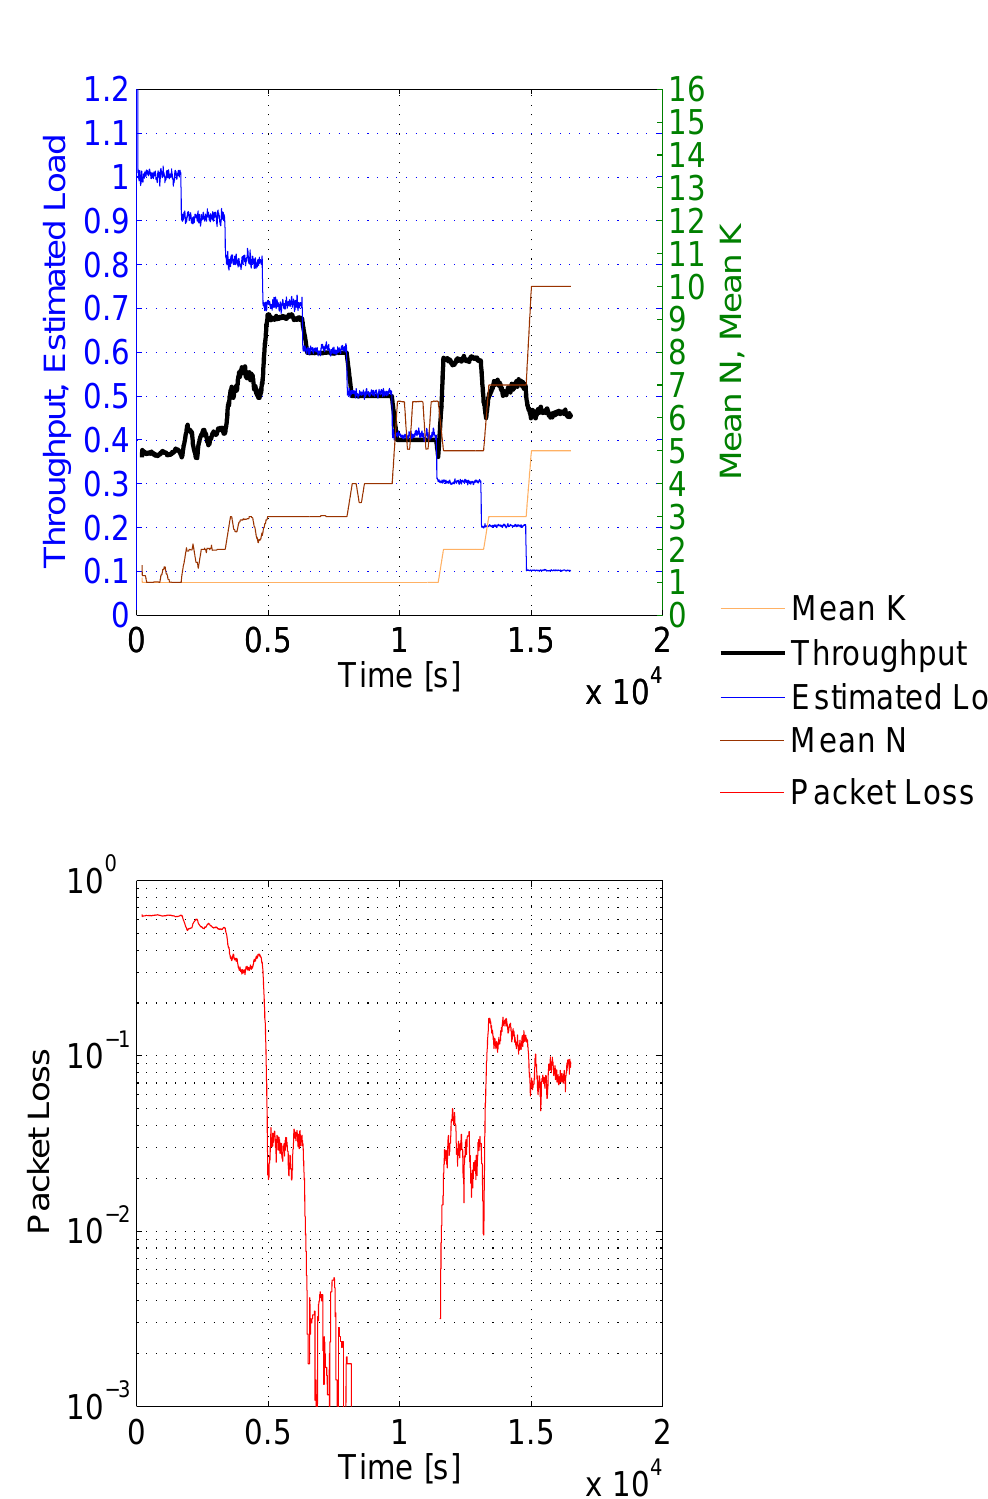
Figure 5. Throughput and Packet Loss for CE algorithm, linear code set C as in Table ??